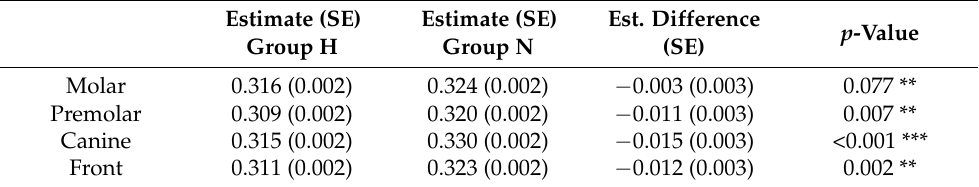
Table 2. Estimated mean [standard error (SE)] for the local thickness values (mm) from group high (H) and narrow (N) aggregated by tooth type. Comparison was achieved using multiple comparison post hoc test with Tukey-method for p -value adjustment (family of 8 estimates). ** p < 0.01, *** p < 0.001.